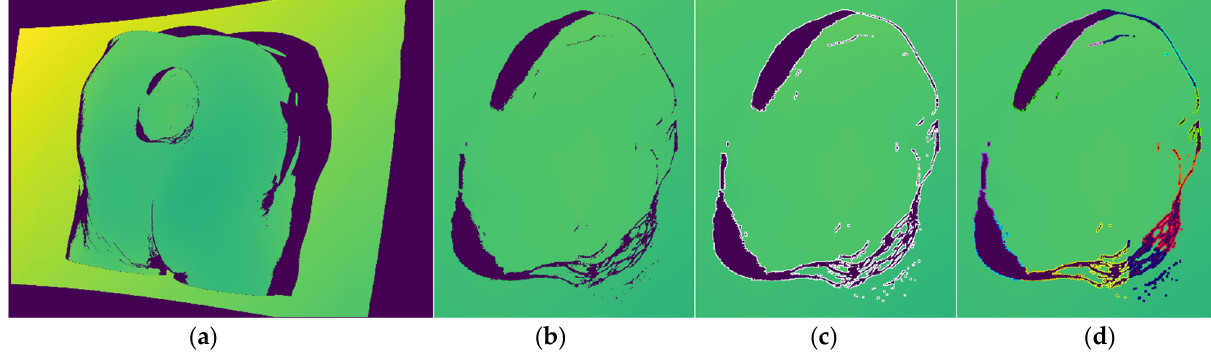
Figure 7. ( a ) Depth image of the medical model recorded by Photoneo Phoxi M; ( b ) close-up view of the wound area as enveloped by the detection algorithm bounding rectangle; ( c ) close-up view with labeled edge points; ( d ) clustered edge points.